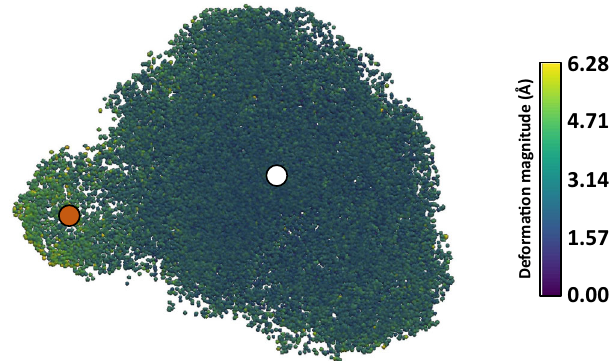
Fig. 1 | EMPIAR-10028 Zernike3D conformational landscape. UMAP repre- sentation of the Zernike3D coef fi cient space for the P. falciparum 80S ribosome (EMPIAR-10028dataset).Thecolormaprepresentsthemodulusofthedeformation fi eldthathastobeappliedtothereferencemaptomatchtheconformationalstate of each particle projection image. Purple colors represent lower deformations (closetothereferencestate).Therepresentationshowsacleardistinctionbetween two different states marked by the white (reference map) and orange (rotated Pf80S state)